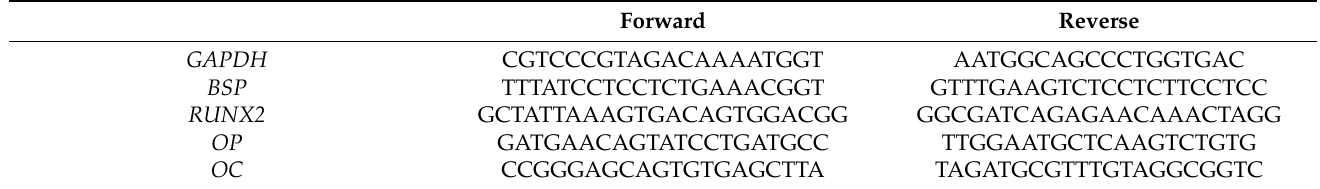
Table 2. The sequence of primers used in the study